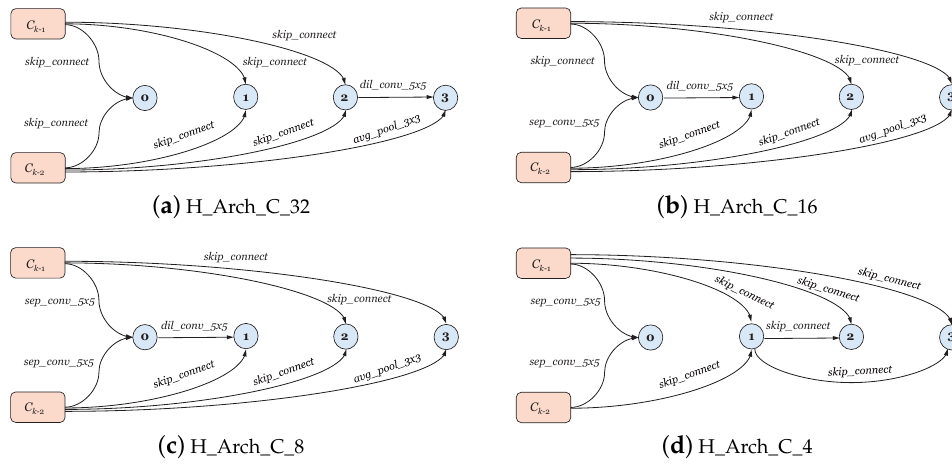
Figure A4. Cell structures obtained over HRSID with ops _ ratio = 0.012.